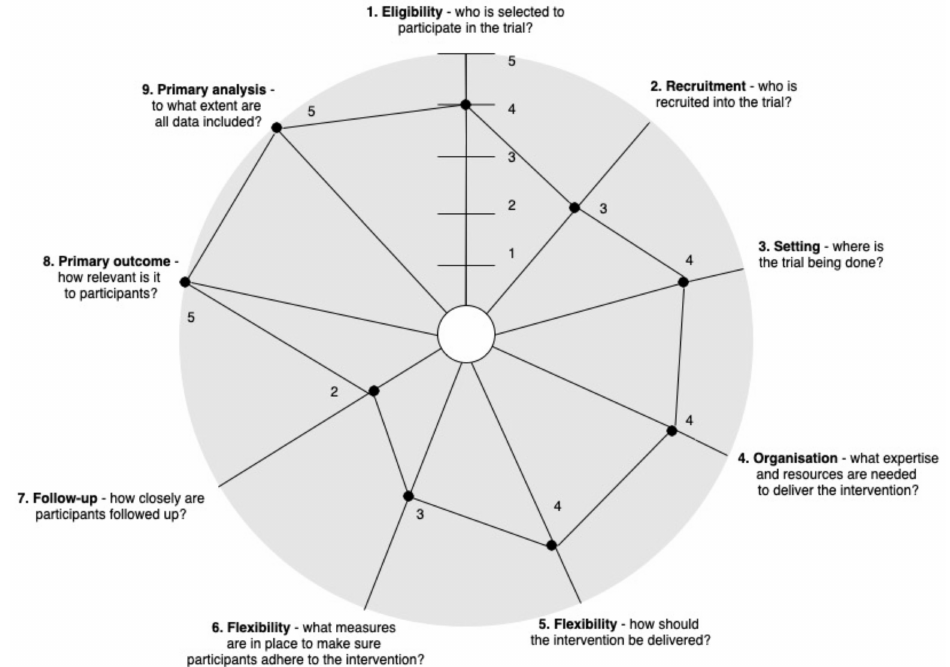
Figure 4. Feasibility evaluation of A-REST intervention according to the PRagmatic Explanatory Continuum Indicator Summary 2 wheel (adapted from